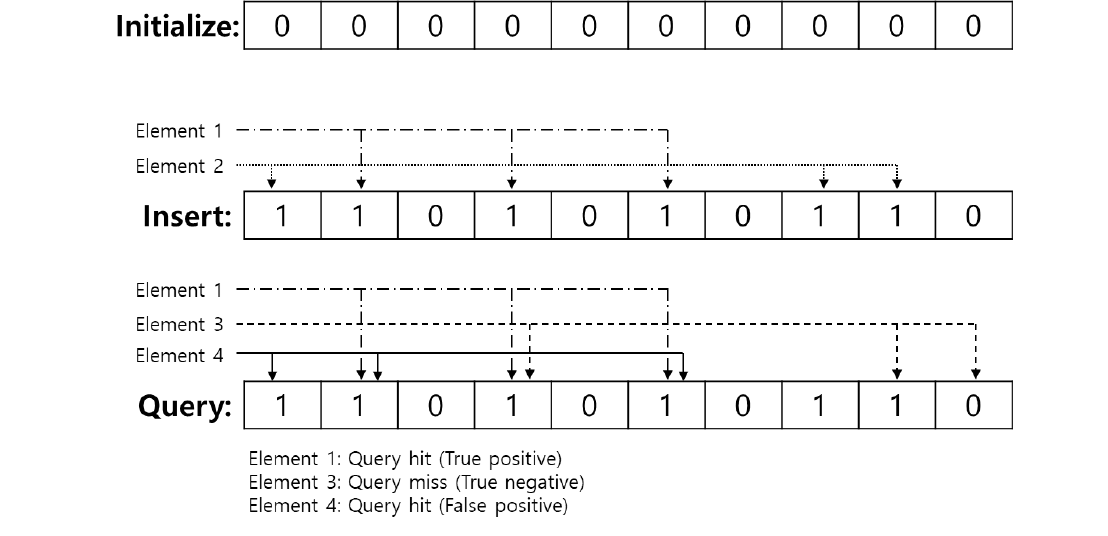
Figure 5. Initialize, Insertion and Query for Bloom